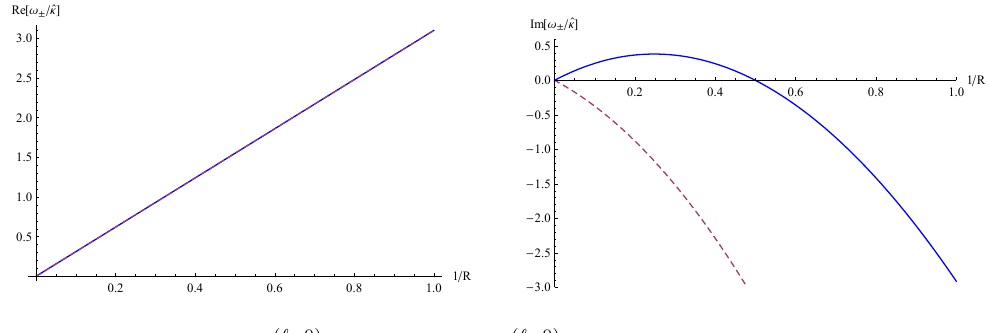
Figure 3 . The frequencies ! ( ‘ =0) (solid line) and ! ( ‘ =0) (dashed line) of the scalar-type quasinormal + (cid:0) modes of the charged black ring with ‘ = 0, m = 2 and b 0 = 0 : 2 . The real part and the imaginary part are depicted in the left and right panel respectively, both of which are in unit of the reduced surface gravity ^ (cid:20) . Im[ ! ( ‘ =0) ] is positive for R > 2 which signals an GL-like +